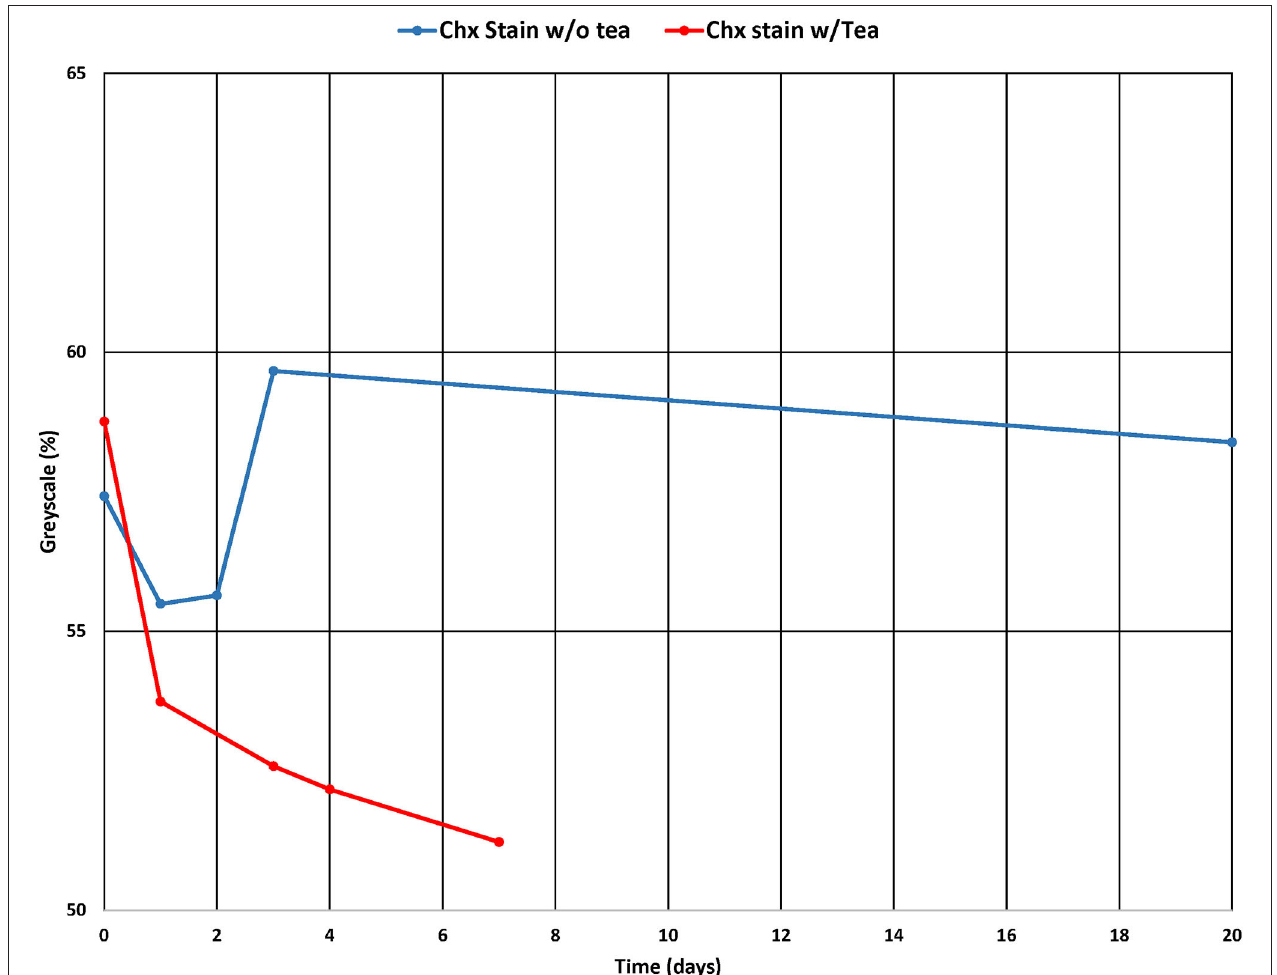
FIGURE 3 | Grayscale % of the control samples and CHX-tea exposed samples over time of the pilot